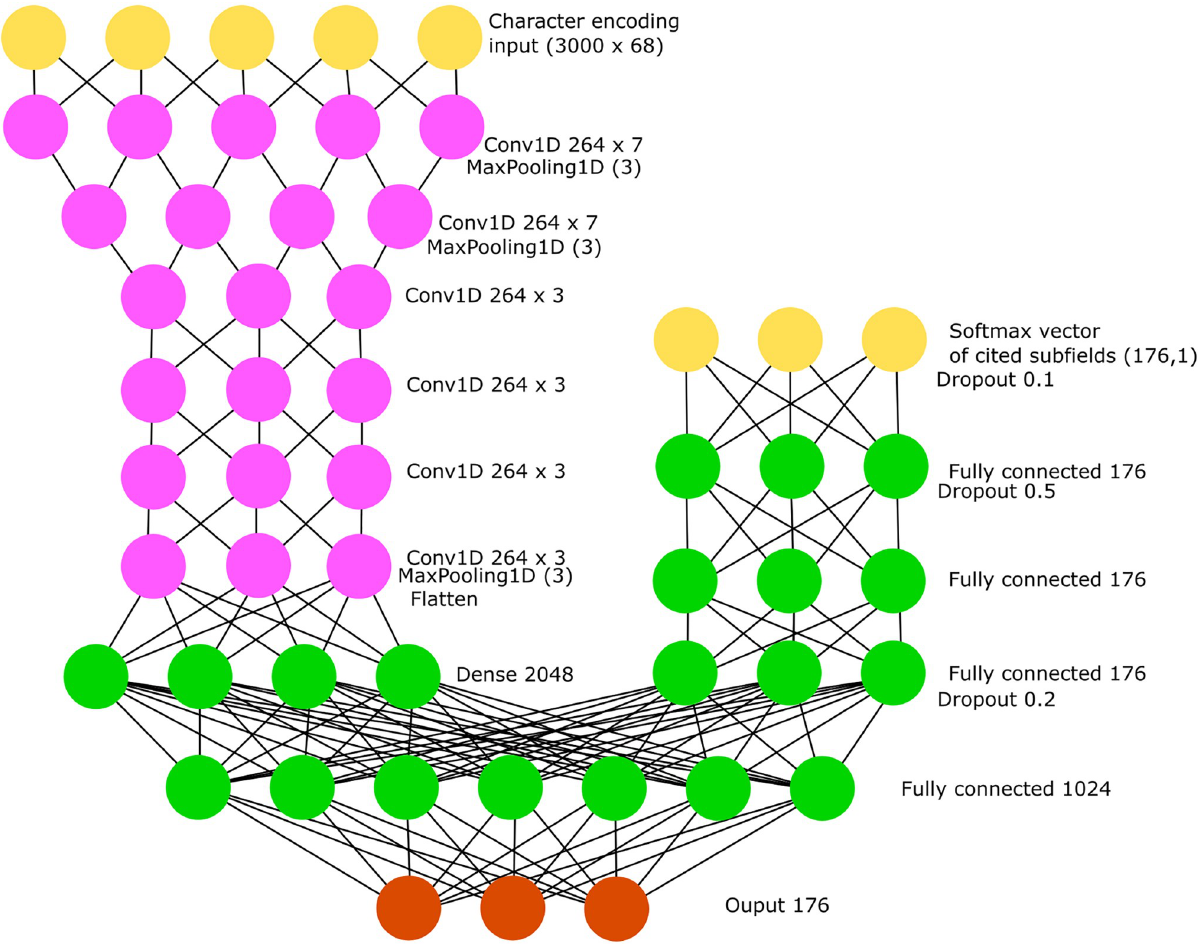
Fig 2. Deep neural network